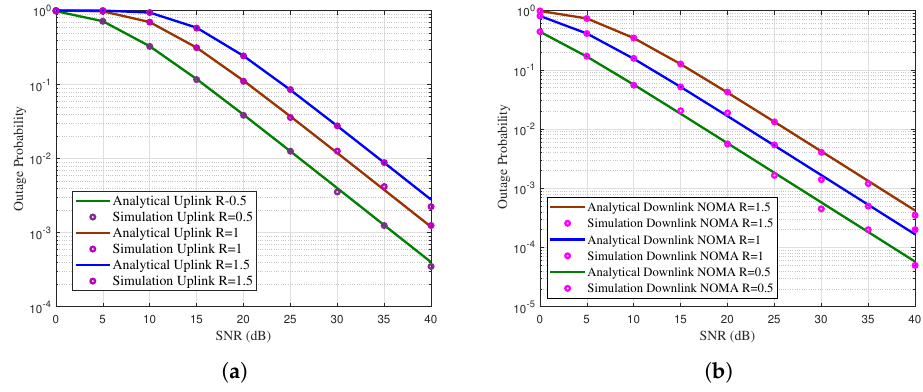
Figure 5. ( a ) Outage probability of the proposed uplink network. ( b ) Outage probability of the proposed downlink